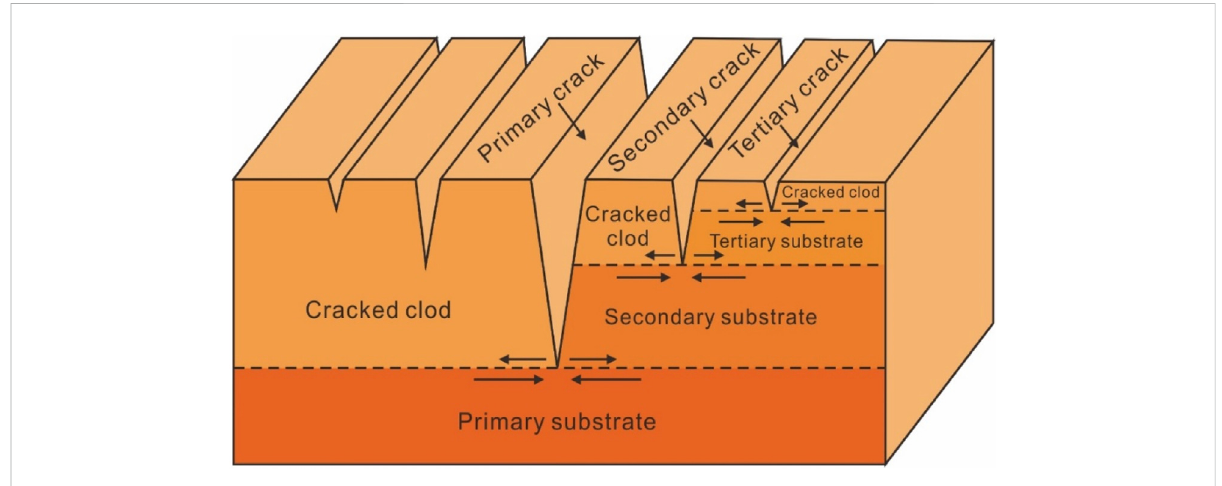
FIGURE 13 Schematiccrackingmodelofspecimenduringdrying.Thenon-propagatingcracksincludethreetypes,i.e.,theprimarycrackcorrespondingto primary substrate, the secondary crack corresponding to secondary substrate, and the tertiary crack corresponding to tertiary